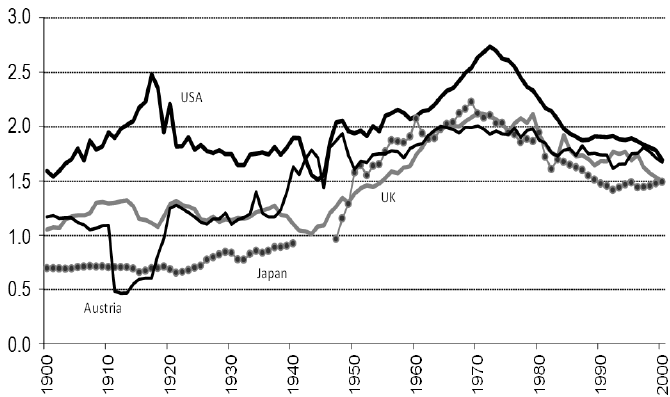
Figure 5. The energy services in relation to GDP. Source: [28] Note: GJ of useful work/1000 US dollars GDP, constant 1990